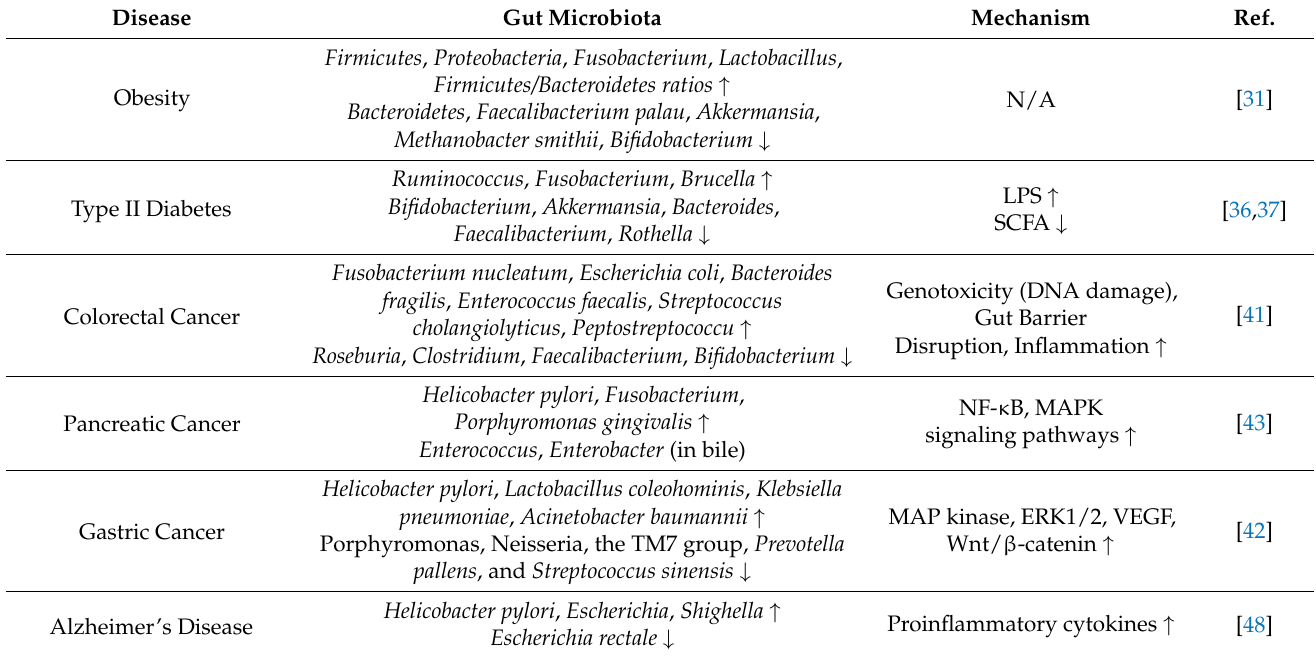
Table 1. Gut microbiota and